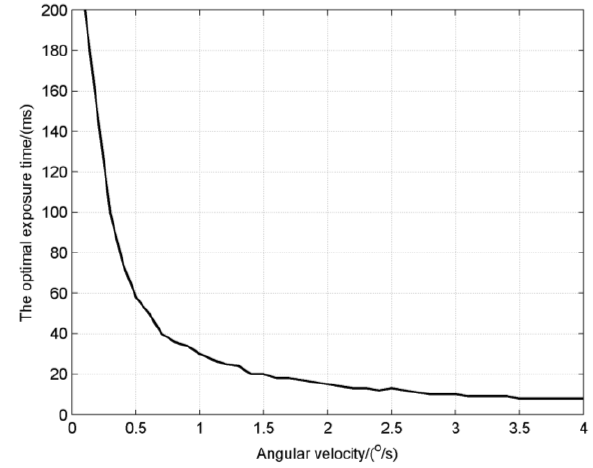
Figure 8. The optimal exposure times at different angular